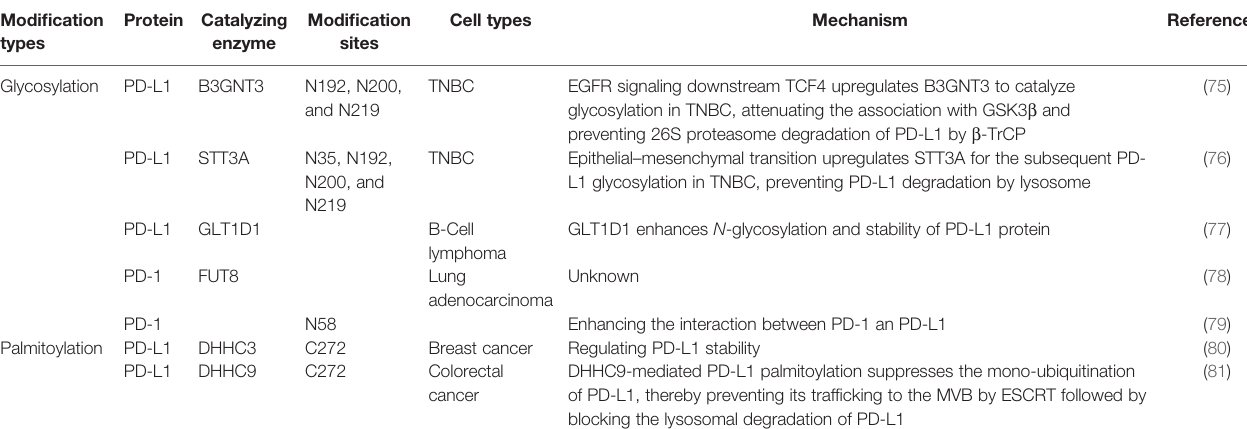
TABLE 1 | Glycosylation and palmitoylation associated with adaptive